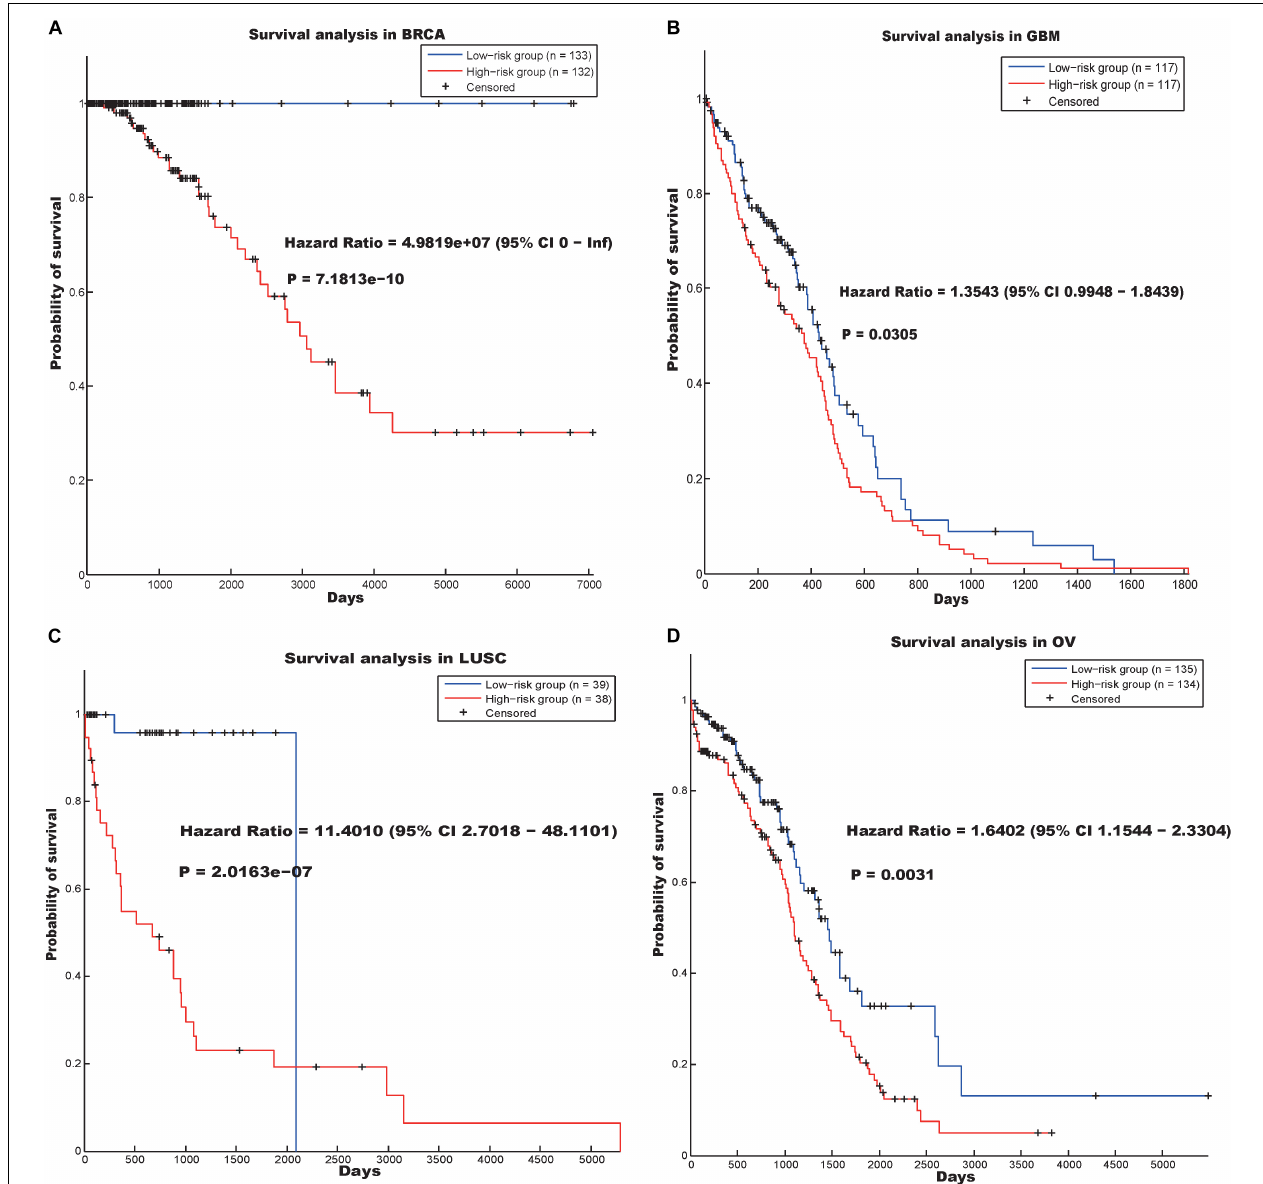
FIGURE 3 | Survival analysis using the hallmark “RNA processing” in four cancer data sets. (A) BRCA, (B) GSM, (C) LUSC and (D)